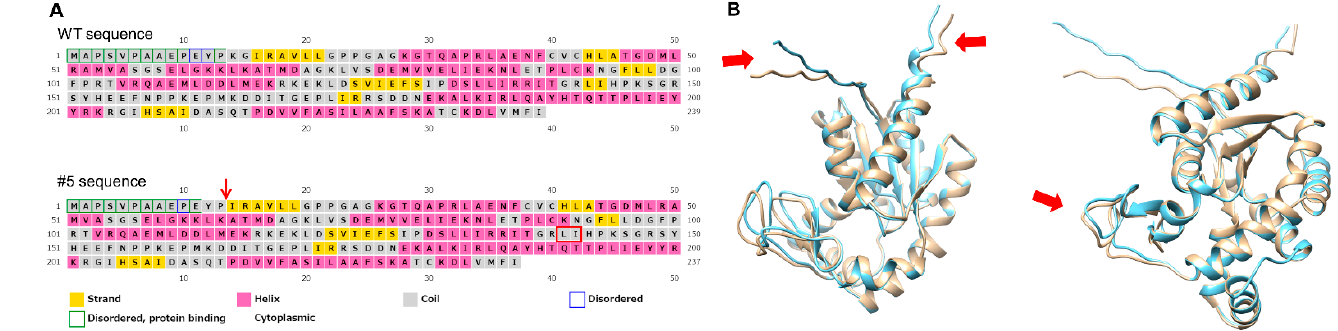
Figure 2. Predicted structures of AK2 protein. ( A ) Secondary structure predictions of AK2 from WT and clone #5. Secondary structures of WT and mutated AK2 were predicted by PSIPRED. Red arrow indicates a deletion site of two amino acids, K and G. Red box indicates a site with changed structure, strand to not strand. ( B ) Tertiary structure predictions and comparison of AK2 from WT and clone #5. Tertiary structure of WT and mutated AK2 were predicted by ColabFold and compared with UCSF Chimera. Blue, WT; yellow, clone #5. Arrows indicate different parts between WT and clone #5.